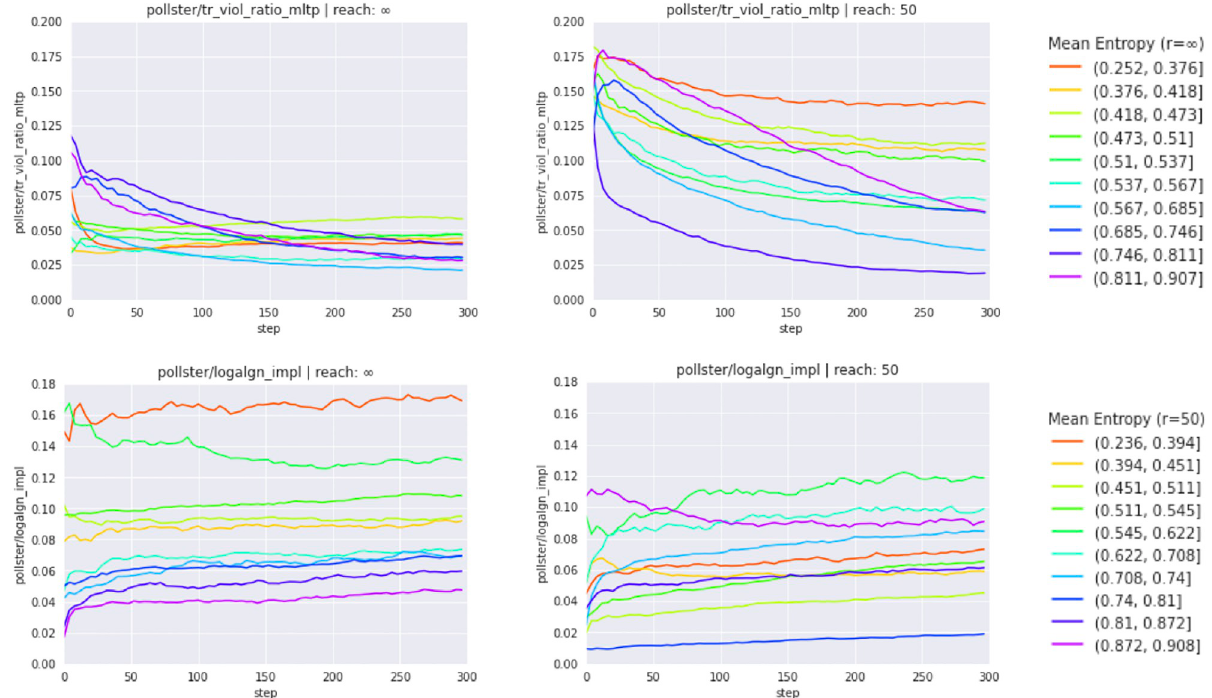
Fig 3. Evolution of consistency metrics. Evolution of consistency metrics T RANS V IOL R ATIO ( transitivity violation ratio ) and L OG A LGN E NT ( entailment alignment ) during self-training. Left: inferentially closed pre-training corpora ( reach = 1 ); right: inferentially incomplete pre-training corpora ( reach =50). Metric evolutions are aggregated over all agents whose belief systems display a similar doxastic entropy (cf. bins to the very right).